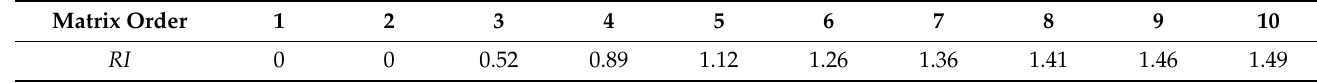
Table 8. Average random consistency